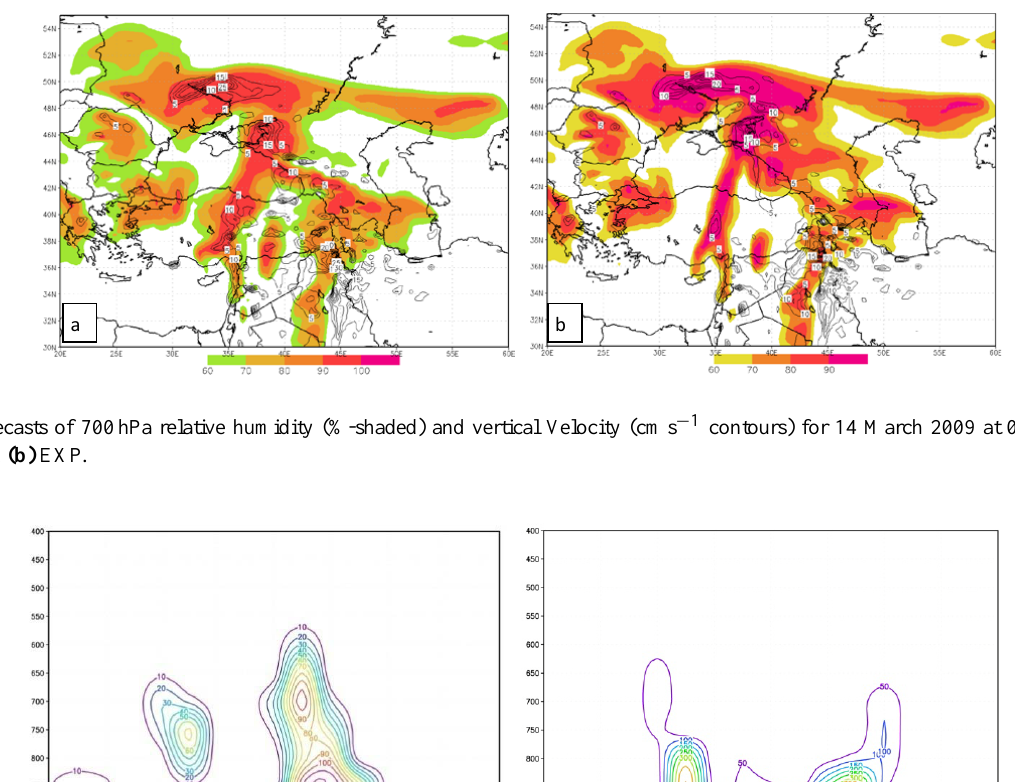
Fig.5.Forecasts of 700 hPa relative vorticity ( 𝑆𝑆 − 1 × 10 5 ) for 14 March 2009 at 0000 UTC for (a) CTL and (b) EXP. Figures 6a and 6b show relative humidity and vertical motion at 700 hPa level. The overall pattern of the relative humidity is similar both in CTL and EXP. Though in the EXP, values of relative humidity and vertical motion ahead of the trough have been increased, such that high values of relative humidity around 100% are now seen over the Azov Sea and Ukraine. These increased values of relative humidity and vertical motion has a direct link with the intensification of the above mentioned cut-off low and hence vertical transport of moisture. For example at the point located at 47° N and 38° E values of vertical motion in the